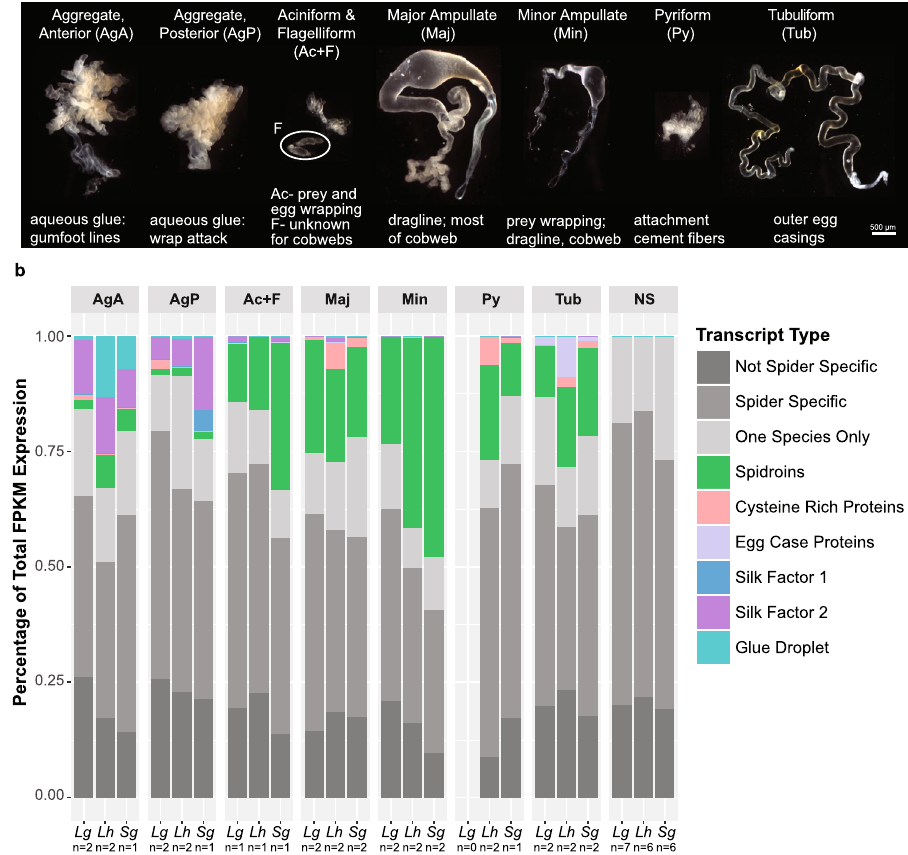
Figure 1. Spider silk gland sampling and proportion of total expression in spider tissues due to known silk structural protein encoding transcripts. ( a ) Representative images of silk gland types sampled (images from L . geometricus ). Functions of each glands’ silk secretions also shown 31, 32, 51, 63 . Flagelliform glands synthesize the axial fiber of the capture spiral in orb-web weavers, but have an unknown function in cobweb weavers. Flagelliform glands are approximately the same size as aciniform glands in Latrodectus and Steatoda ; the single pair of flagelliform glands was included with the multitude of aciniform glands in which they were nestled (Ac + F). ( b ) Proportion of total mean FPKM (fragments aligned per thousand base pairs per million aligned fragments) shown for transcripts classified according to BLASTX homology to known spider silk structural proteins (colors, see Supplementary File 1); only a spider non-silk structural protein (light grey); or to a protein found outside of spiders (dark grey, see Supplementary File 2). Transcripts without a BLASTX alignment to published proteins and that did not align with any other species’ transcripts using BlastClust are shown as “One Species Only” (lightest grey). Lg = Latrodectus geometricus , Lh = L . hesperus , Sg = Steatoda grossa . n = number of biological replicates for each tissue type (see also Supplementary Fig. S1). Multiple individuals were combined to generate sufficient RNA for each